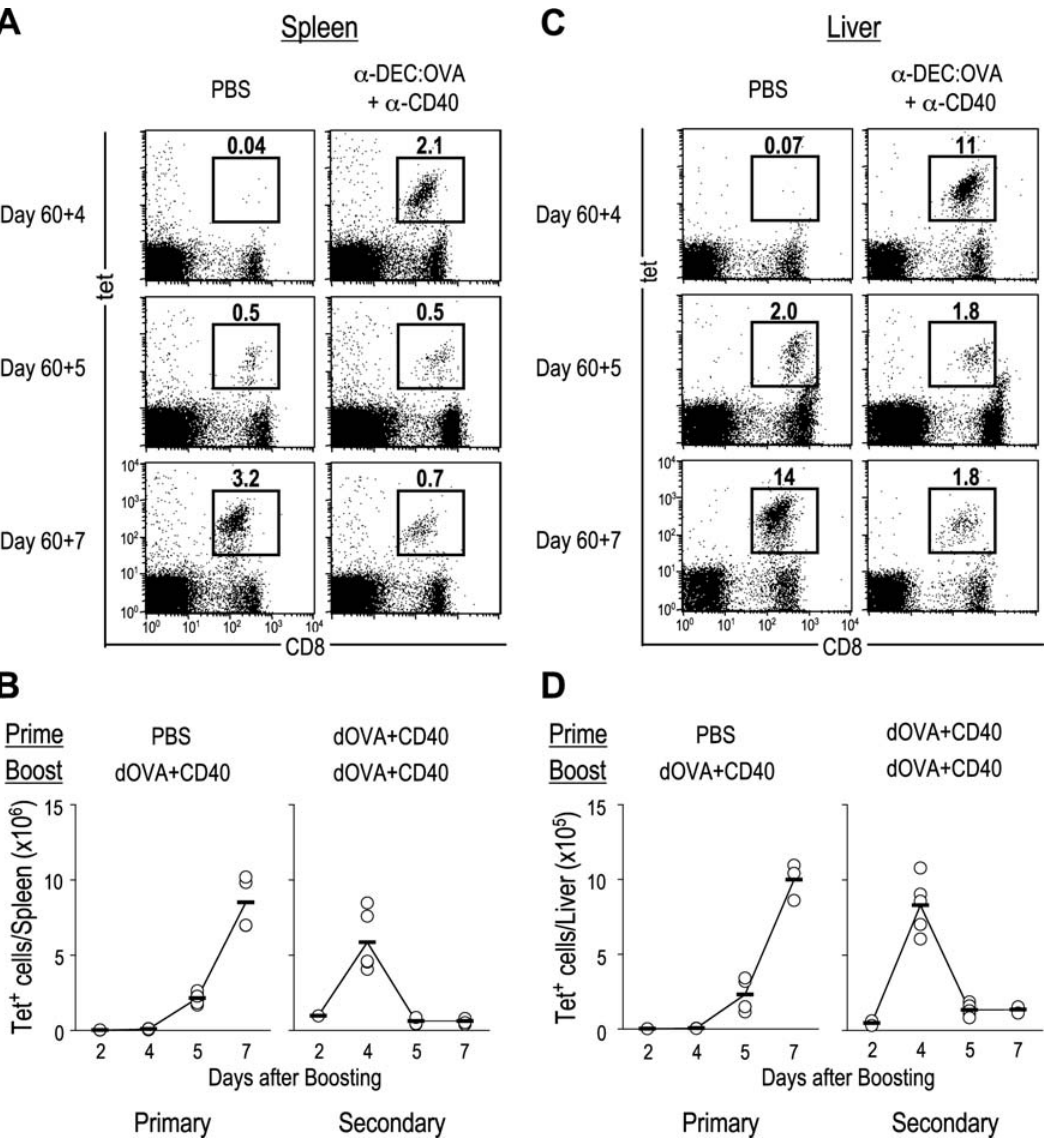
Figure 1. DEC-205 targeting in the presence of agonistic anti-CD40 generates memory CD8 + T cells. (A–D) B6 mice were primed with PBS or anti-DEC:OVA + anti-CD40, and boosted with anti-DEC:OVA + anti-CD40 at d 60. (A, C) Frequency of OVA-specific CD8 + T cells in spleen (A) and liver (C) at day 4, 5, and 7 after booster immunization. Numbers are % of lymphocytes. Representative of five experiments. (B, D) Total number of OVA-specific CD8 + T cells per spleen (B) and liver (D) after boosting, where each symbol represents data from different